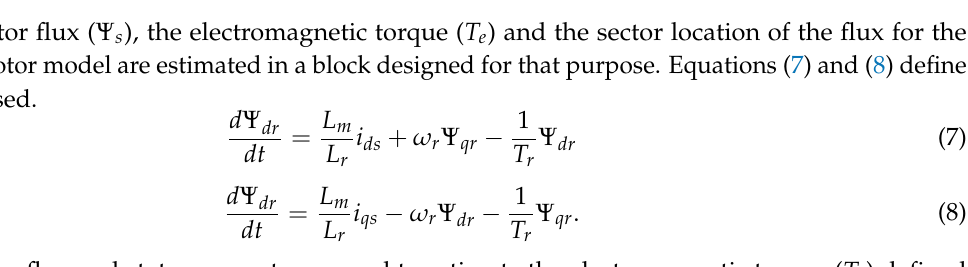
Figure 3. Current model direct torque control